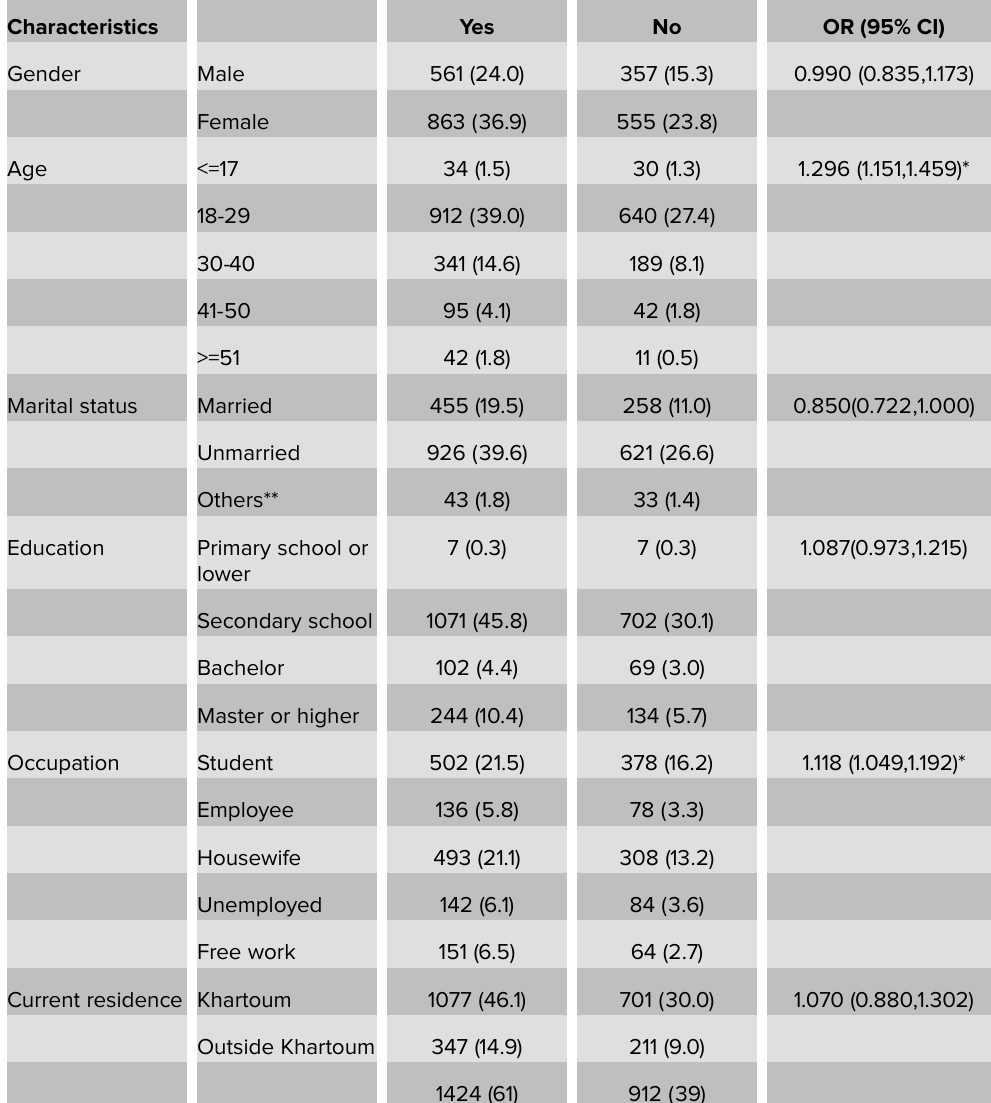
TABLE 4: Attitudes towards COVID-19 by demographic variables, (do you have to believe that Sudan can win against the COVID-19 virus?)